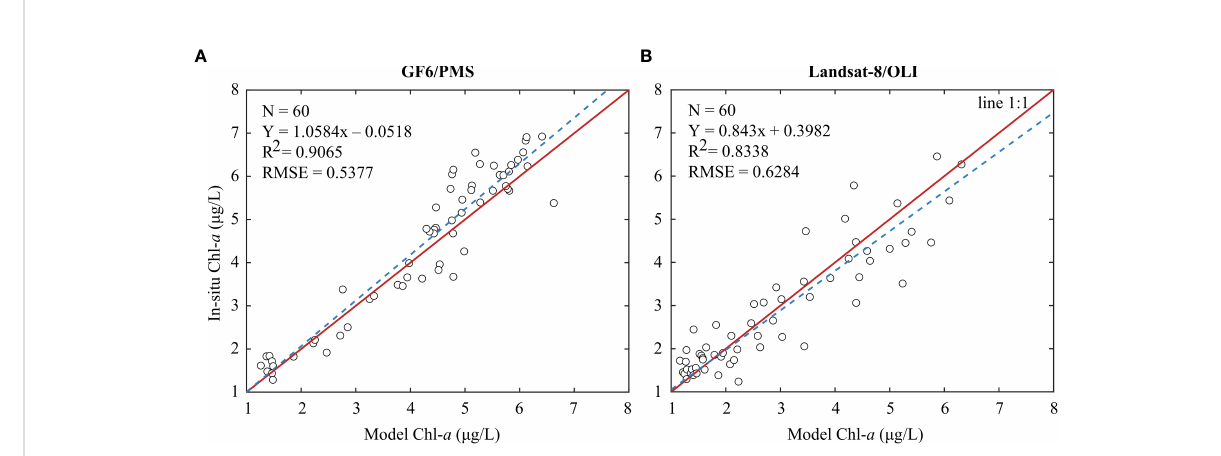
FIGURE 3 Correlation analysis between model and in-situ Chl- a values. (A) Comparison of Chl- a value of GF-6/PMS model with in-situ Chl- a value; (B) Comparison of Chl- a value of Landsat8/OLI model with in-situ Chl- a value. The x coordinate is the reference value, the y coordinate is the in-situ value, and the unit is